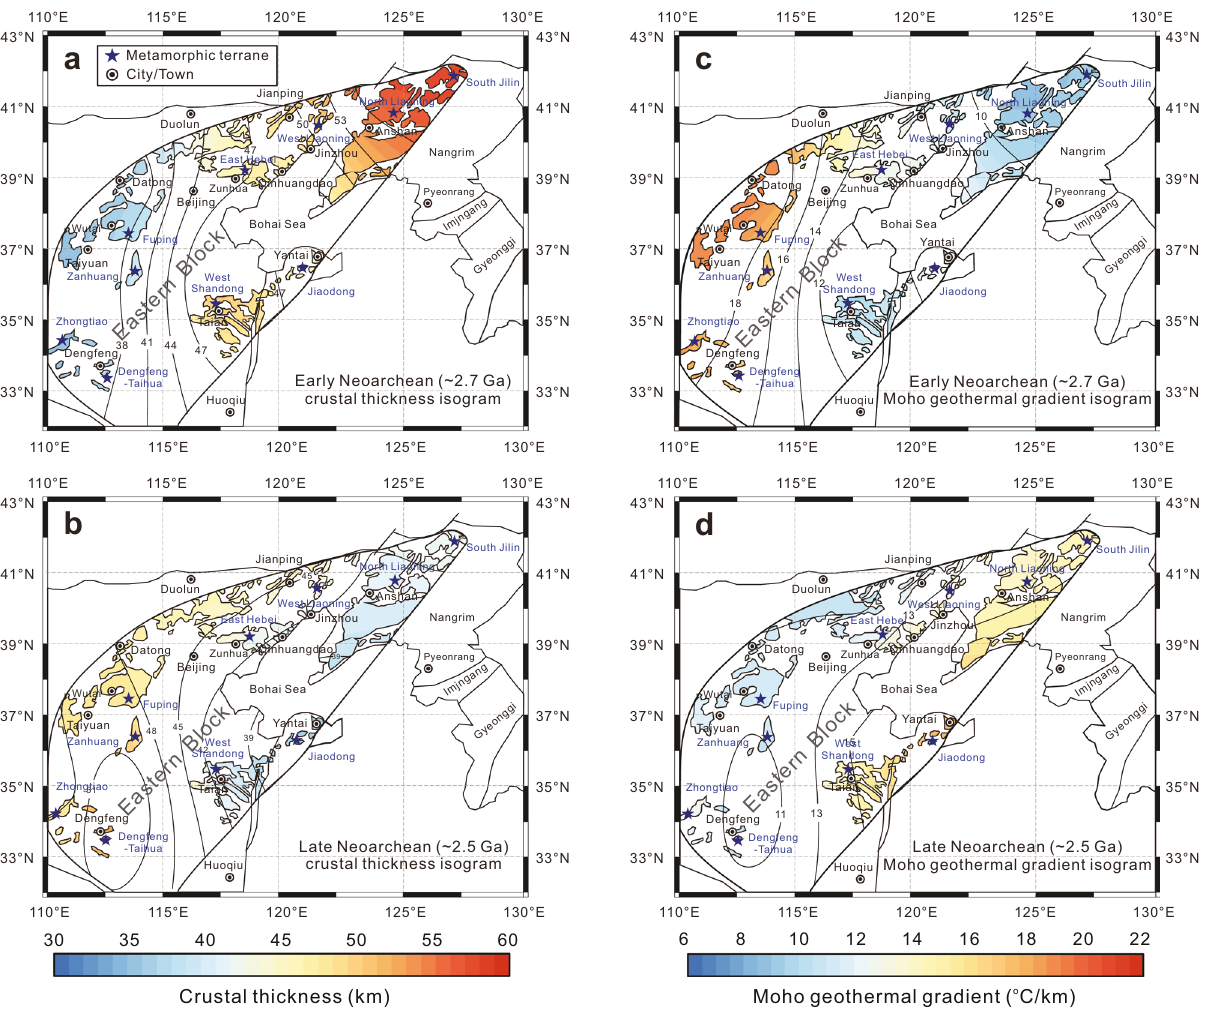
Fig. 6 Contour color plots of crustal thickness and Moho geothermal gradient in the Eastern Block of the North China Craton at different periods (modi fi ed from Wang et al. 48 ). a Early Neoarchean (~2.7 Ga) crustal thickness isogram; b late Neoarchean (~2.5 Ga) crustal thickness isogram; c early Neoarchean (~2.7 Ga) Moho geothermal gradient isogram; d late Neoarchean (~2.5 Ga) Moho geothermal gradient